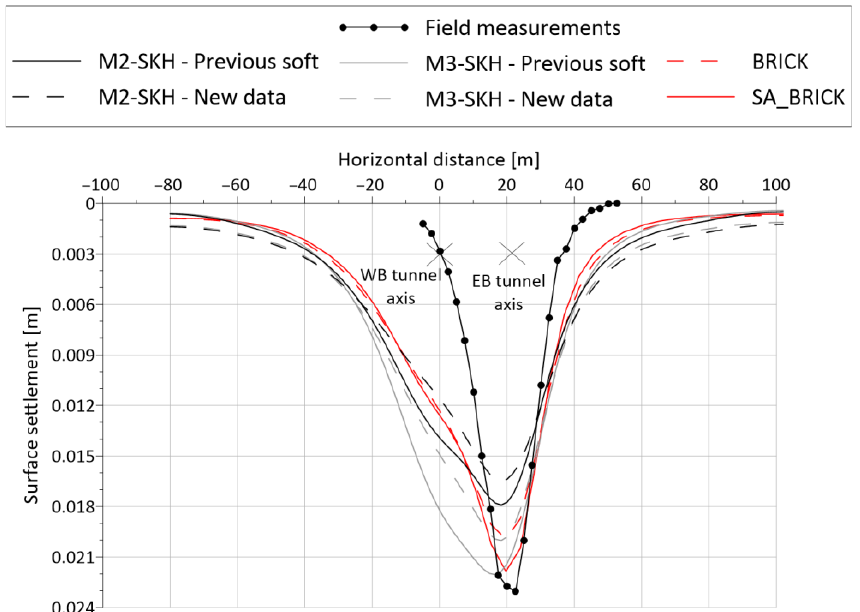
Figure 16. Results of modelling of the excavation of the east tube using different kinematic harden- ing models.